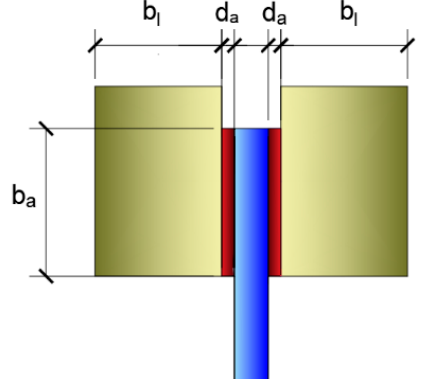
Figure 4. Geometry and usage symbols of the adhesive joint.